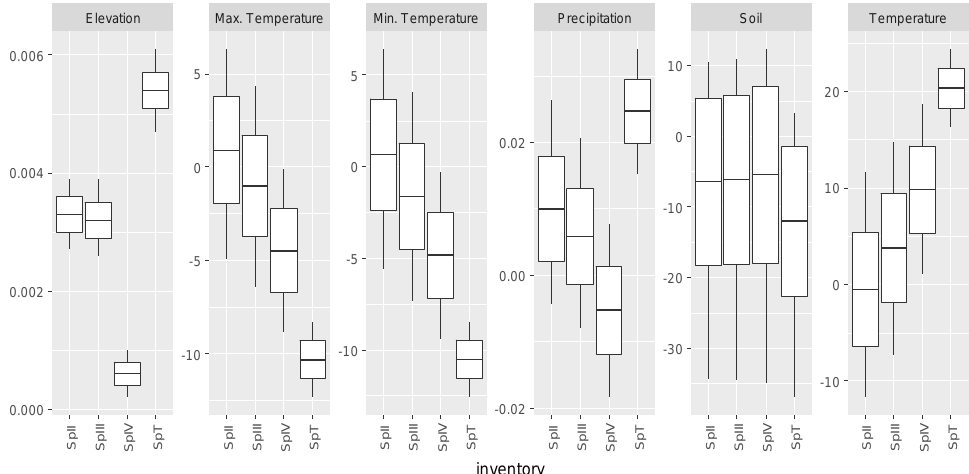
Figure 8. Boxplot diagram for the posterior estimates of the covariates for P. pinaster models: Spatial model II inventory (SpII); Spatial model III inventory (SpIII); Spatial model IV inventory (SpIV); Spatio-temporal model (SpT).